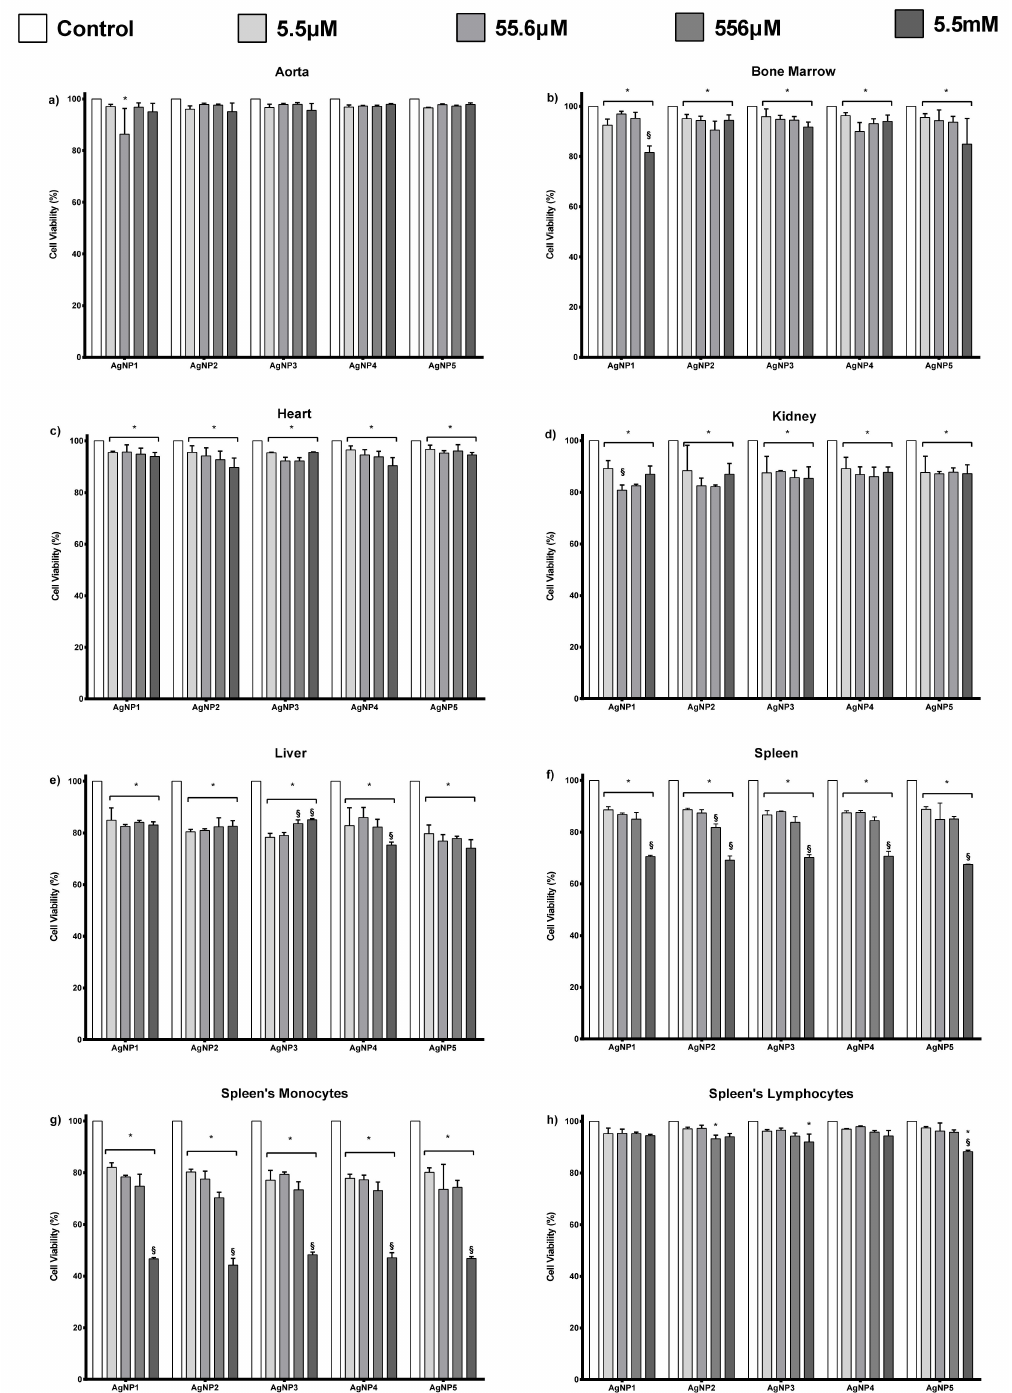
Figure 4. Cell viability of mouse primary culture exposed for 24 h to different concentrations (5.5 µ M, 55.6 µ M, 556 µ M and 5.5 mM) of AgNP1–AgNP5 quantified by flow cytometry. ( a ) Aorta, ( b ) bone marrow, ( c ) heart, ( d ) kidney, ( e ) liver and ( f ) spleen. Items ( g , h ) show the cell viability of monocytes and lymphocytes obtained from the spleen; cell populations differentiated by size and granularity. * represents statistically significant differences ( p < 0.05) compared with negative control and § represents statistically significant differences ( p < 0.05) between the assessed concentrations of each AgNP